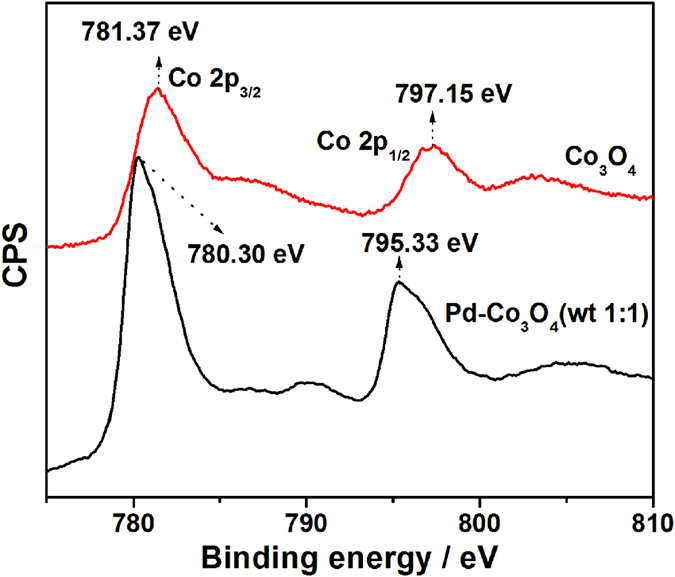
XPS spectra of Co 2p for mesoporous Co3O4 and mesoporous Pd-Co3O4 (wt 1:1).